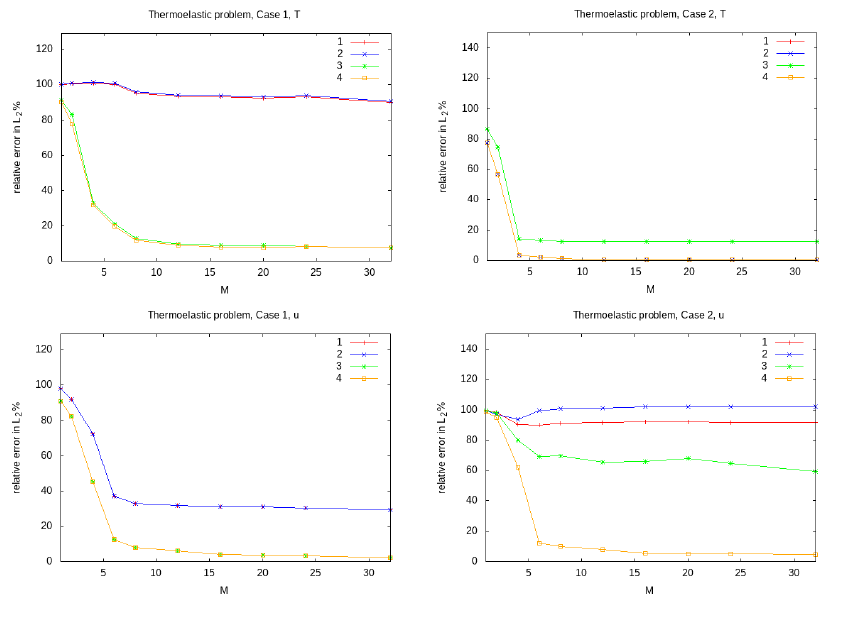
Figure A4. Thermoelasticity problem. Temperature ( top ) and Displacement ( bottom ). Case 1 and Case 2: Relative L 2 error with a different number of multiscale basis functions. (1) M u g = M u , M u p = 0 and M T g = M T , M T p = 0; (2) M u g = M u , M u p = 0, and M T g = M T p = M T ; (3) M u g = M u p = M u